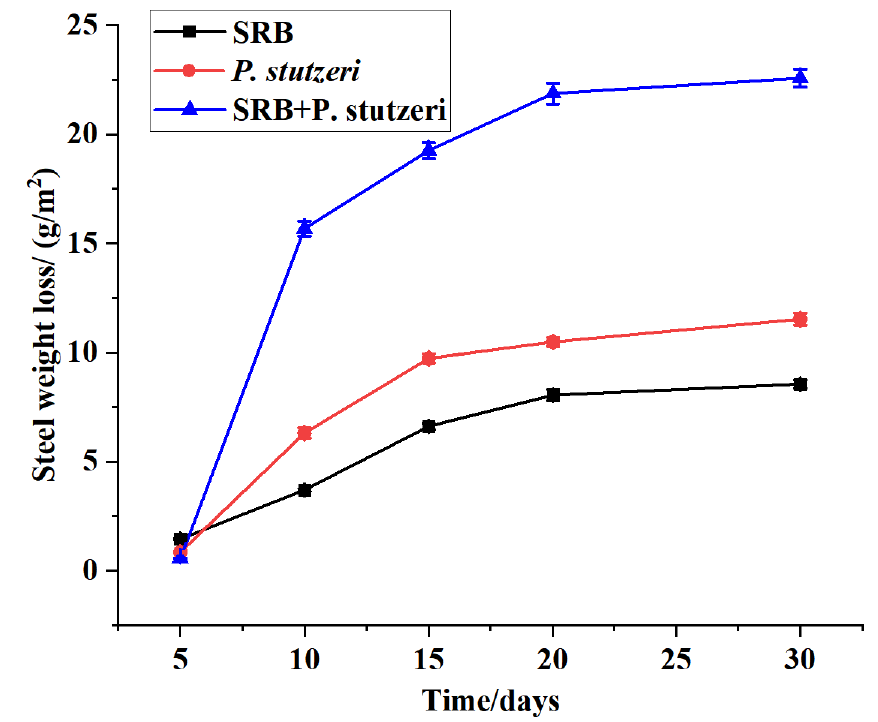
Figure 7. Weight loss curves of X70 steel under different test